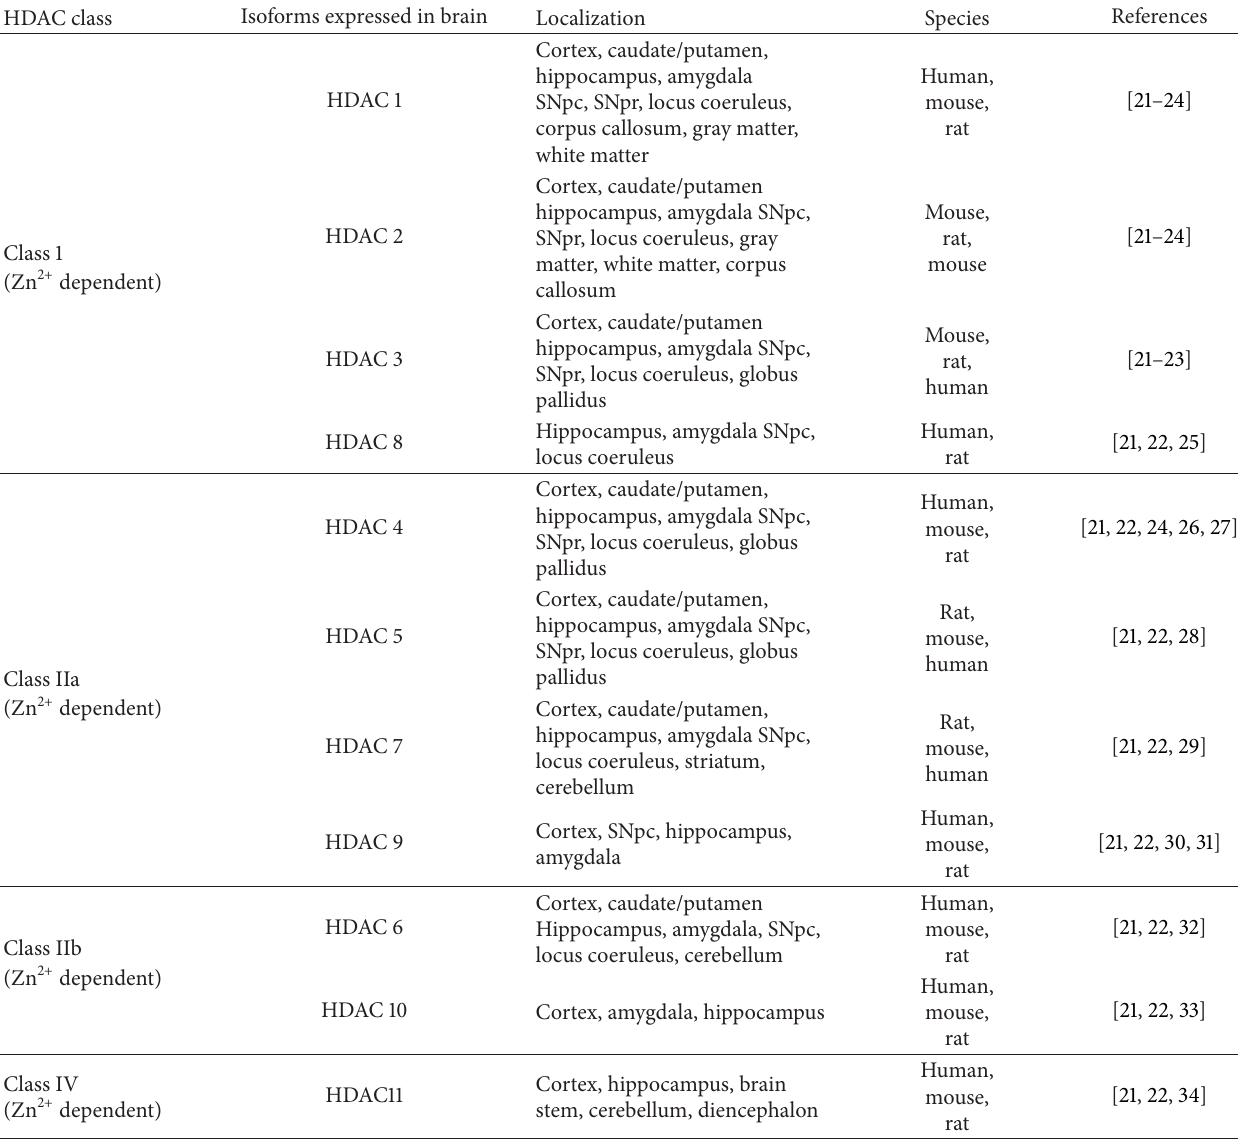
Table 1: Histone deacetylases in